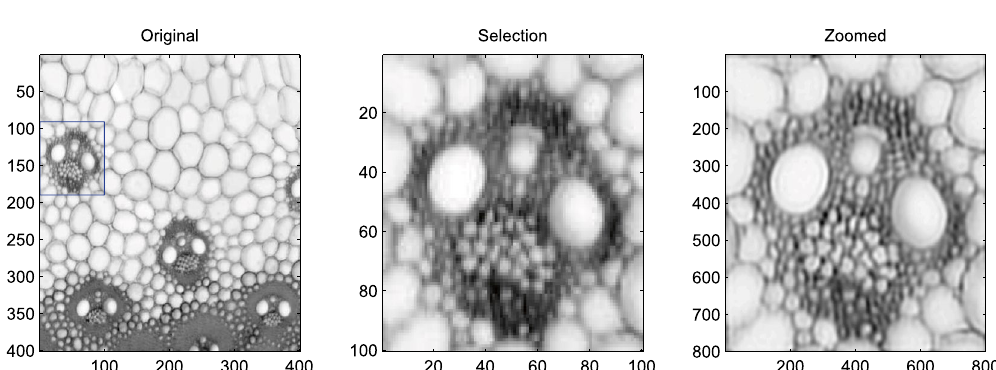
Figure 7. Single image super resolution of the Stem cells image. Left panel: a 400 × 400 selection of the observed image. Middle panel: the 100 × 100 pixel selection (indicated by a blue square in the left panel). Right panel: super-resolution with a factor